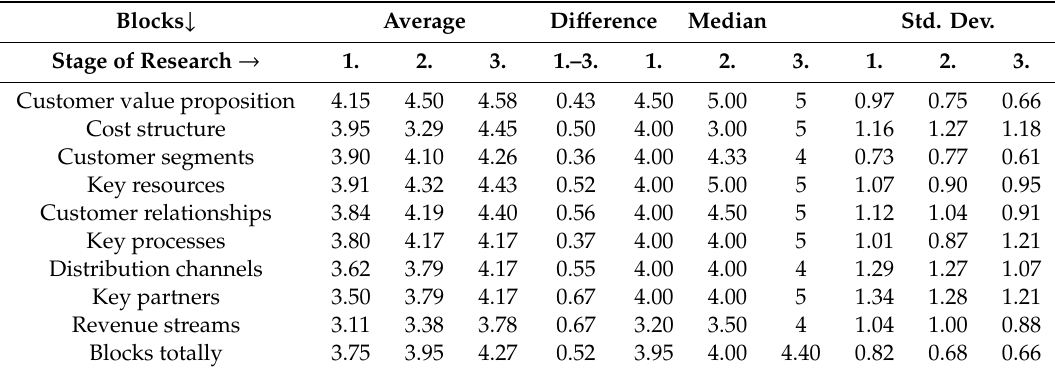
Table 1. Degree of model blocks